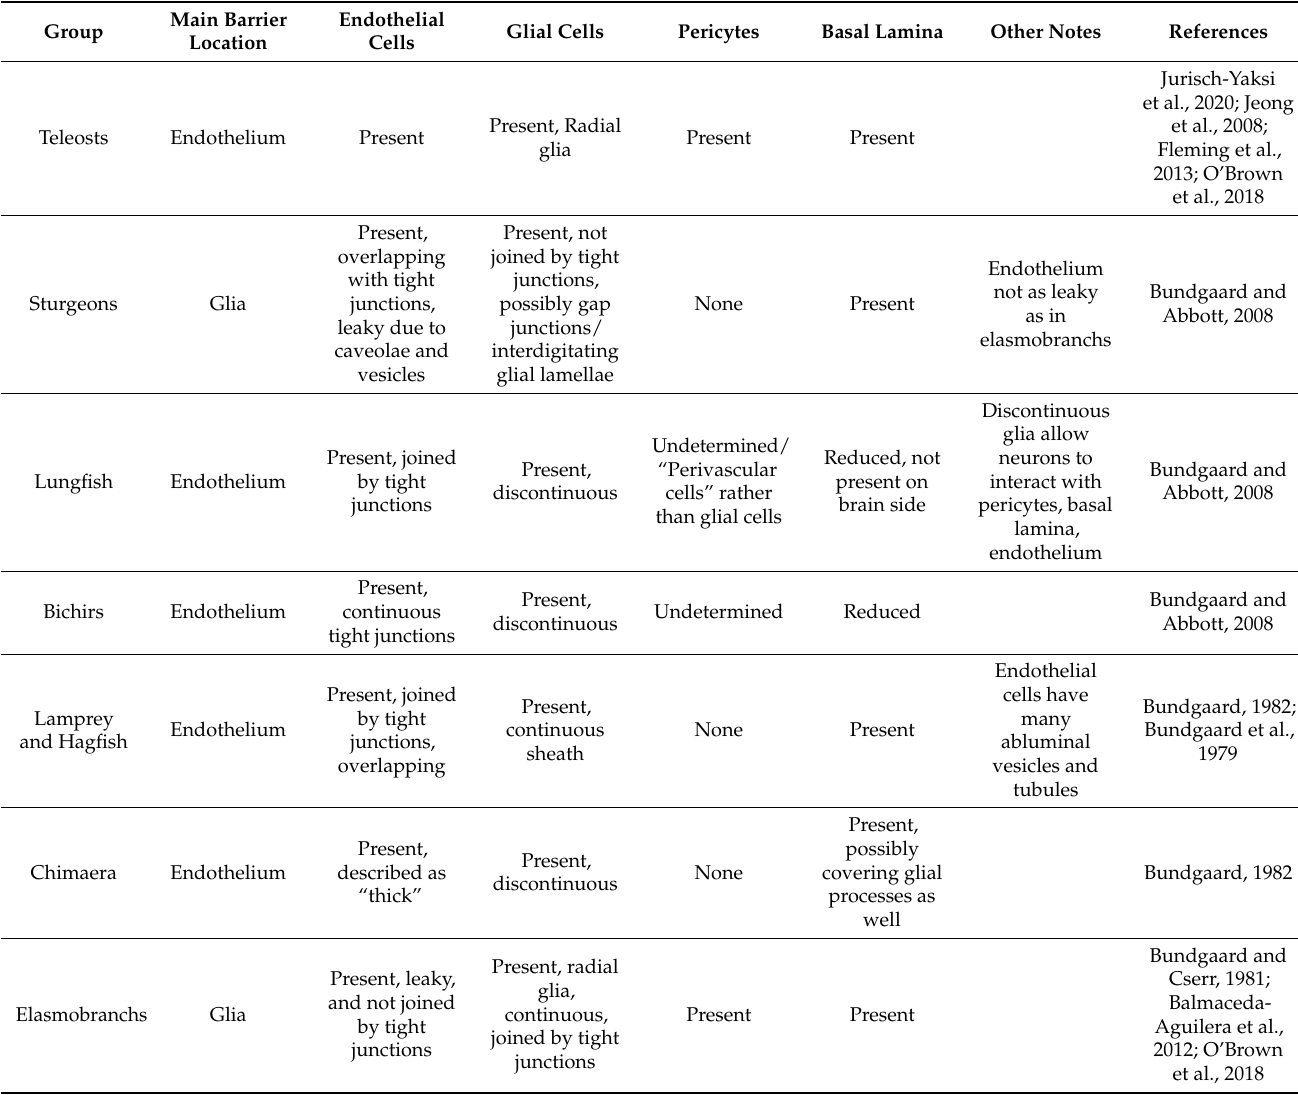
Table 1. Differences in the neurovascular unit of